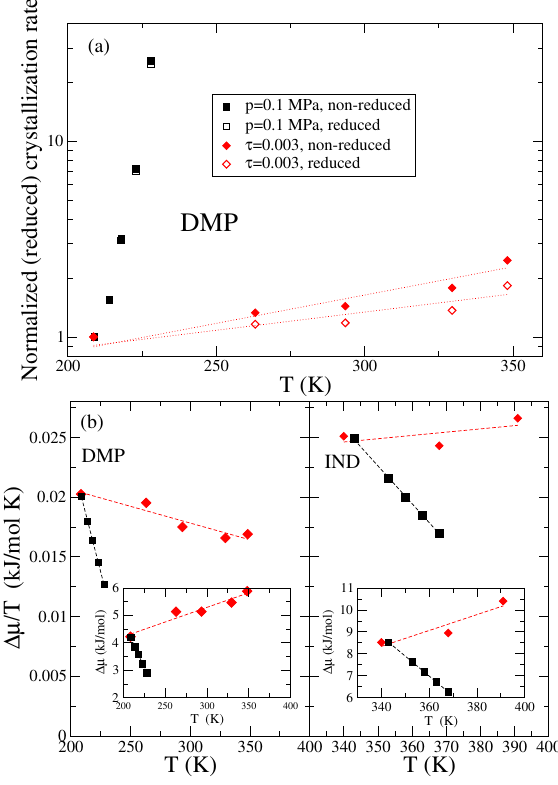
Figure 1: Revisiting isochronal crystallization data: (a) DMP crystallization rates [ 32 ] , also in reduced units, on isochrone versus isobar. To compare trends all data, both non-reduced and reduced, have been normalized by the respective values for pressure 0.1 MPa, temperature 209 K. (b) Estimated driving force ∆ µ normalised by temperature (i.e. in reduced units) for (left) DMP, and (right) indomethacin [ 33 ] ; in both cases the squares are data along the isobar p = 0.1MPa, while diamonds are data along the isochrone τ = 0.003s. The inset shows the data without normalisation by temperature. Dashed lines are linear fits to show